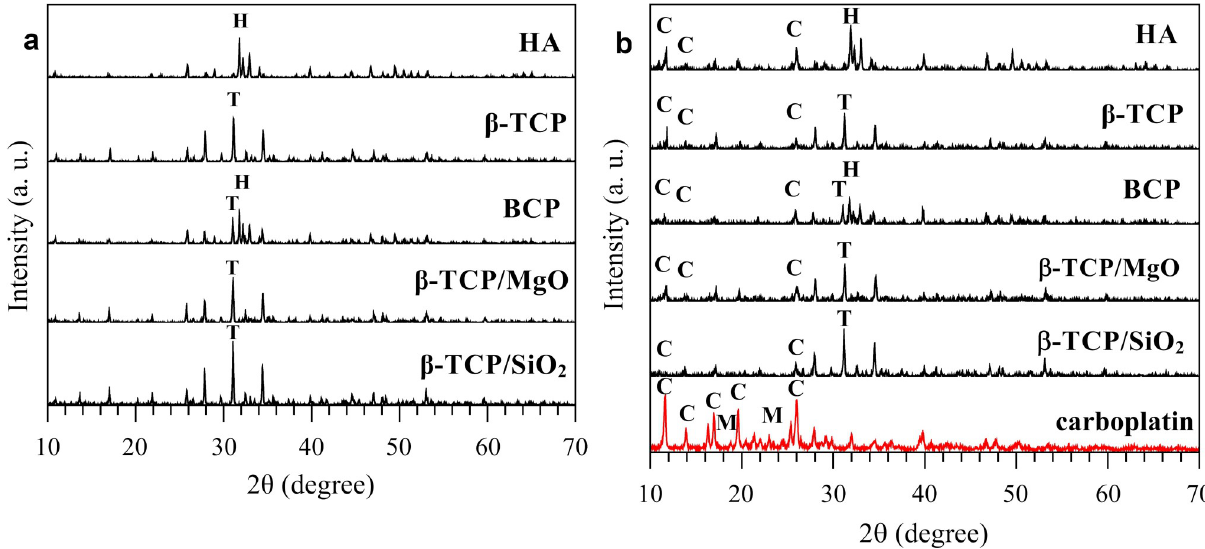
Fig 4. X-ray diffraction analysis of the biomaterials before and after drug loading. (a) detected characteristics hydroxyapatite (H) and β -TCP (T) peaks in the calcium phosphates (CaPs) before drug loading; (b) carboplatin (C) peaks in biomaterials after drug loading process in the 70 mg/g concentration, compared with the drug that presented carboplatin (C) and mannitol peaks (M).